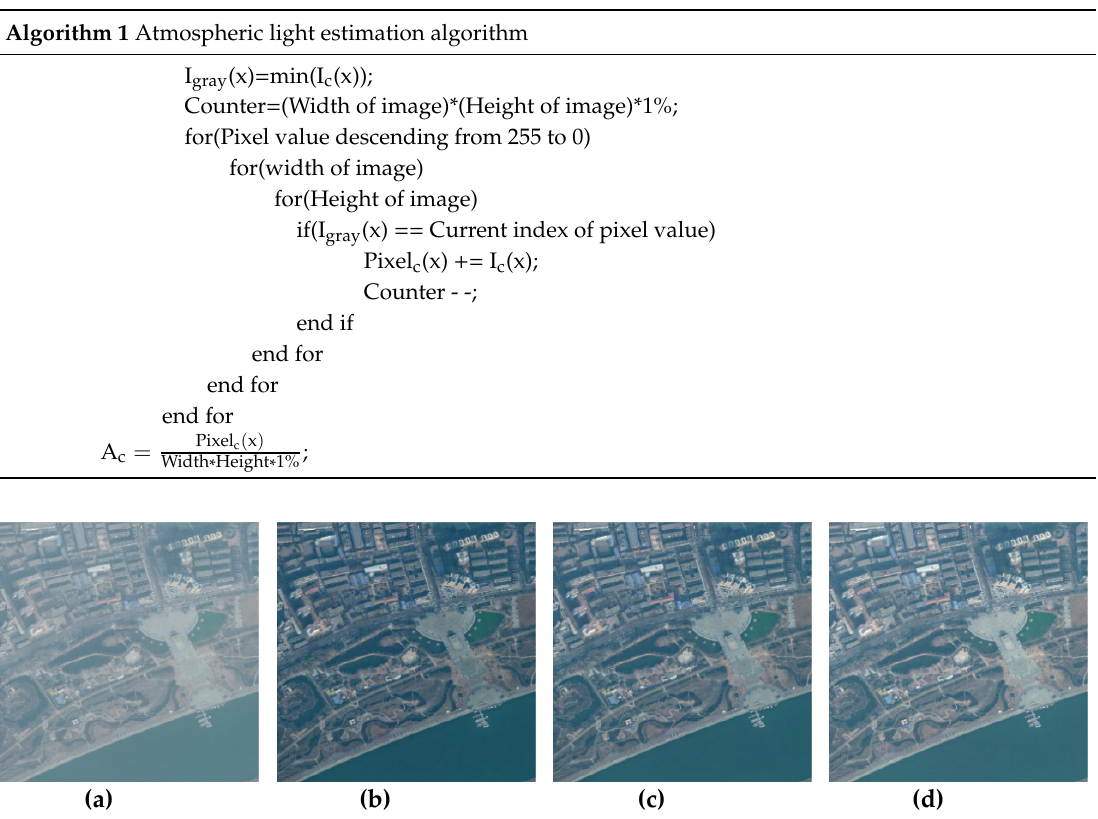
Figure 14. Comparison diagram of restored images with different proportions of atmospheric light values. ( a ) Original haze satellite image; ( b ) The first 0.1% of bright atmospheric light; ( c ) The first 1% of bright atmospheric light; ( d ) The first 10% of bright atmospheric light.